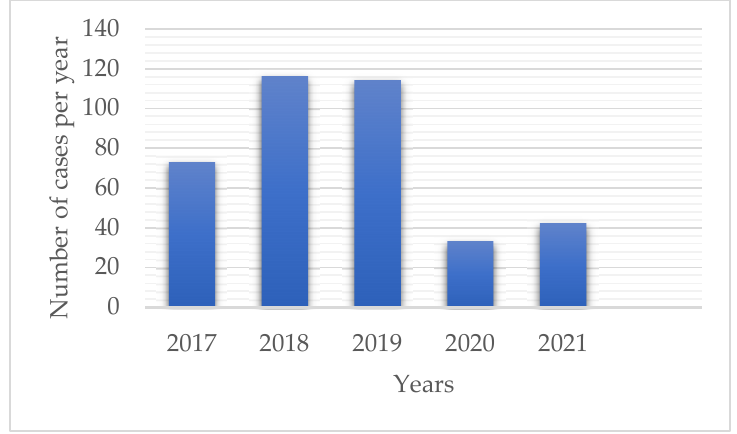
Figure 1. The number of diagnosed melanoma patients per year (01/JAN/17-31/DEC/21). A significant reduction in the number of diagnosed cases during the pandemic was observed ( p = 0.036). The studied samples were comprised of 219 (55.7%) males and 174 (44.3%) females. Overall, the majority of studied patients were in the 60–80 age group (Table 1). The median patient age in the prepandemic group was 68.0 (range 19.0–97.0), while in the